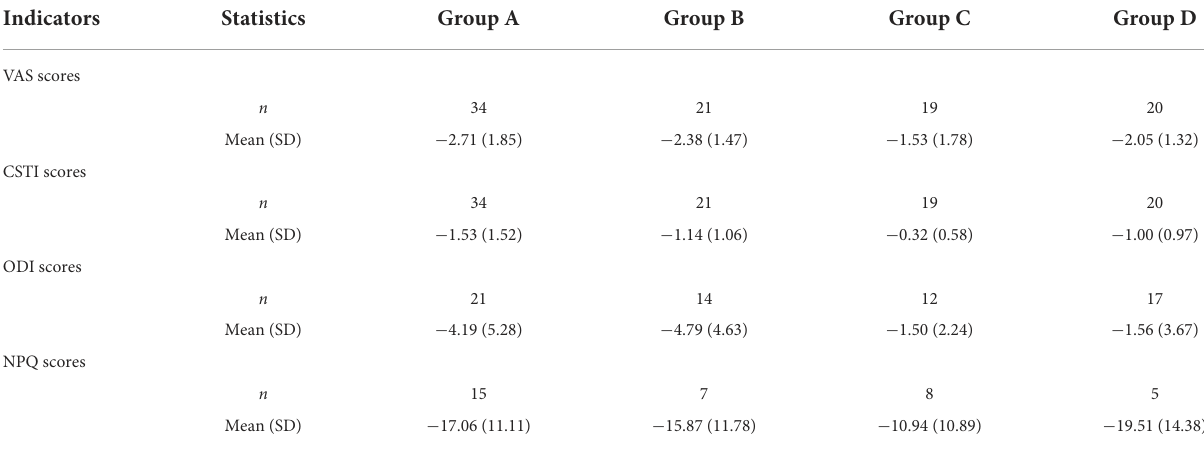
TABLE 7 Intergroup comparison of changes in secondary indicators from baseline for each group.